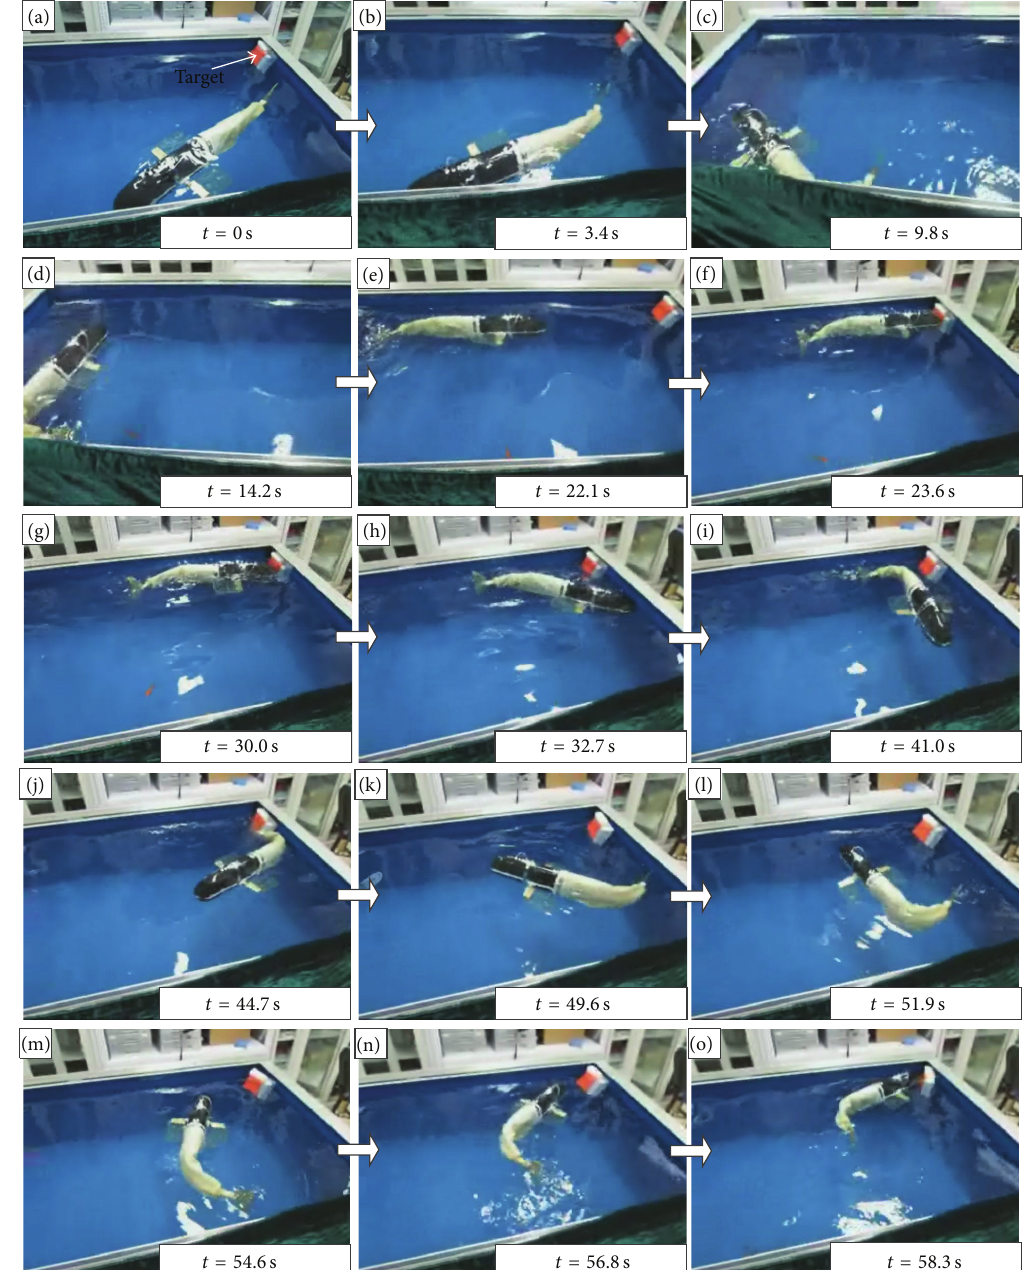
Figure 14: Snapshot sequence of an overall target search and